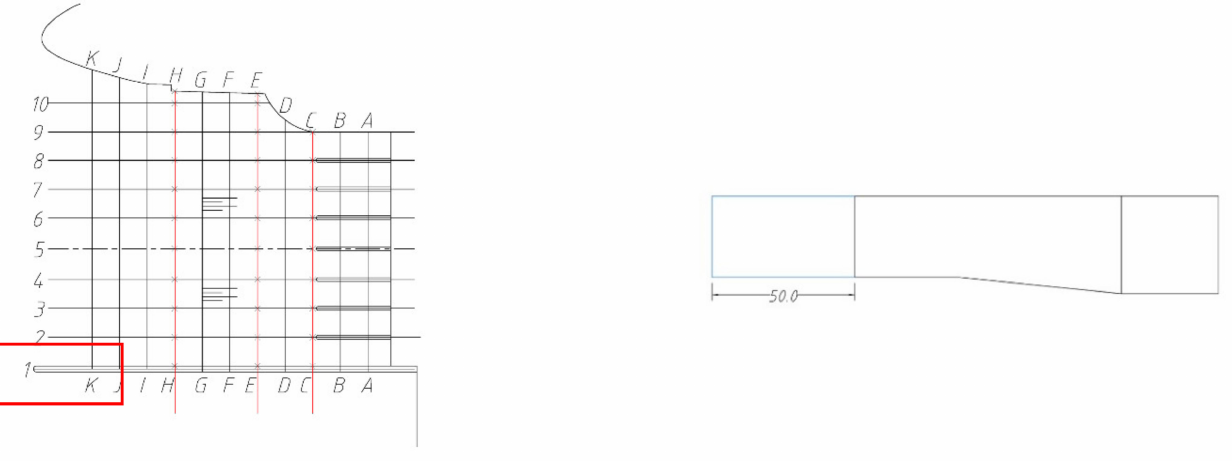
Figure 8. Plan 2 (unit: cm).